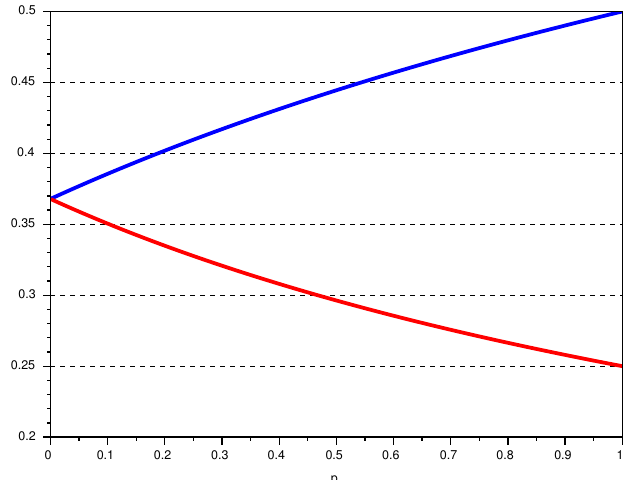
Figure 2. Value of the problem v ∗ (red line) and threshold u ∗ (blue line) as a function of parameter p . For p = 0, set u ∗ = v ∗ = e − 1